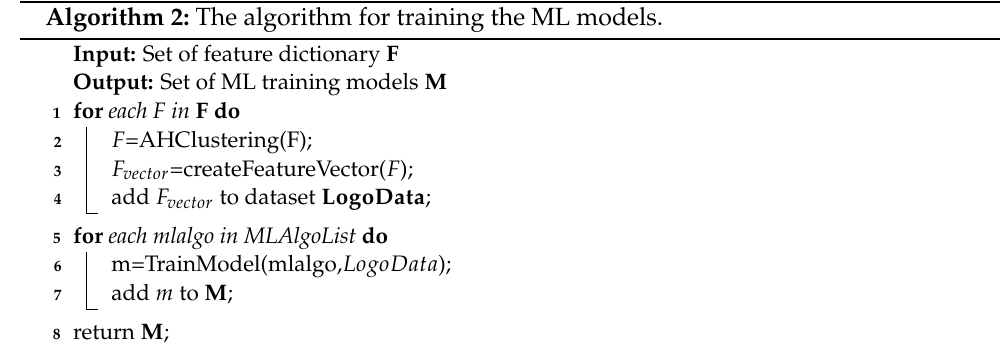
Algorithm 2: The algorithm for training the ML